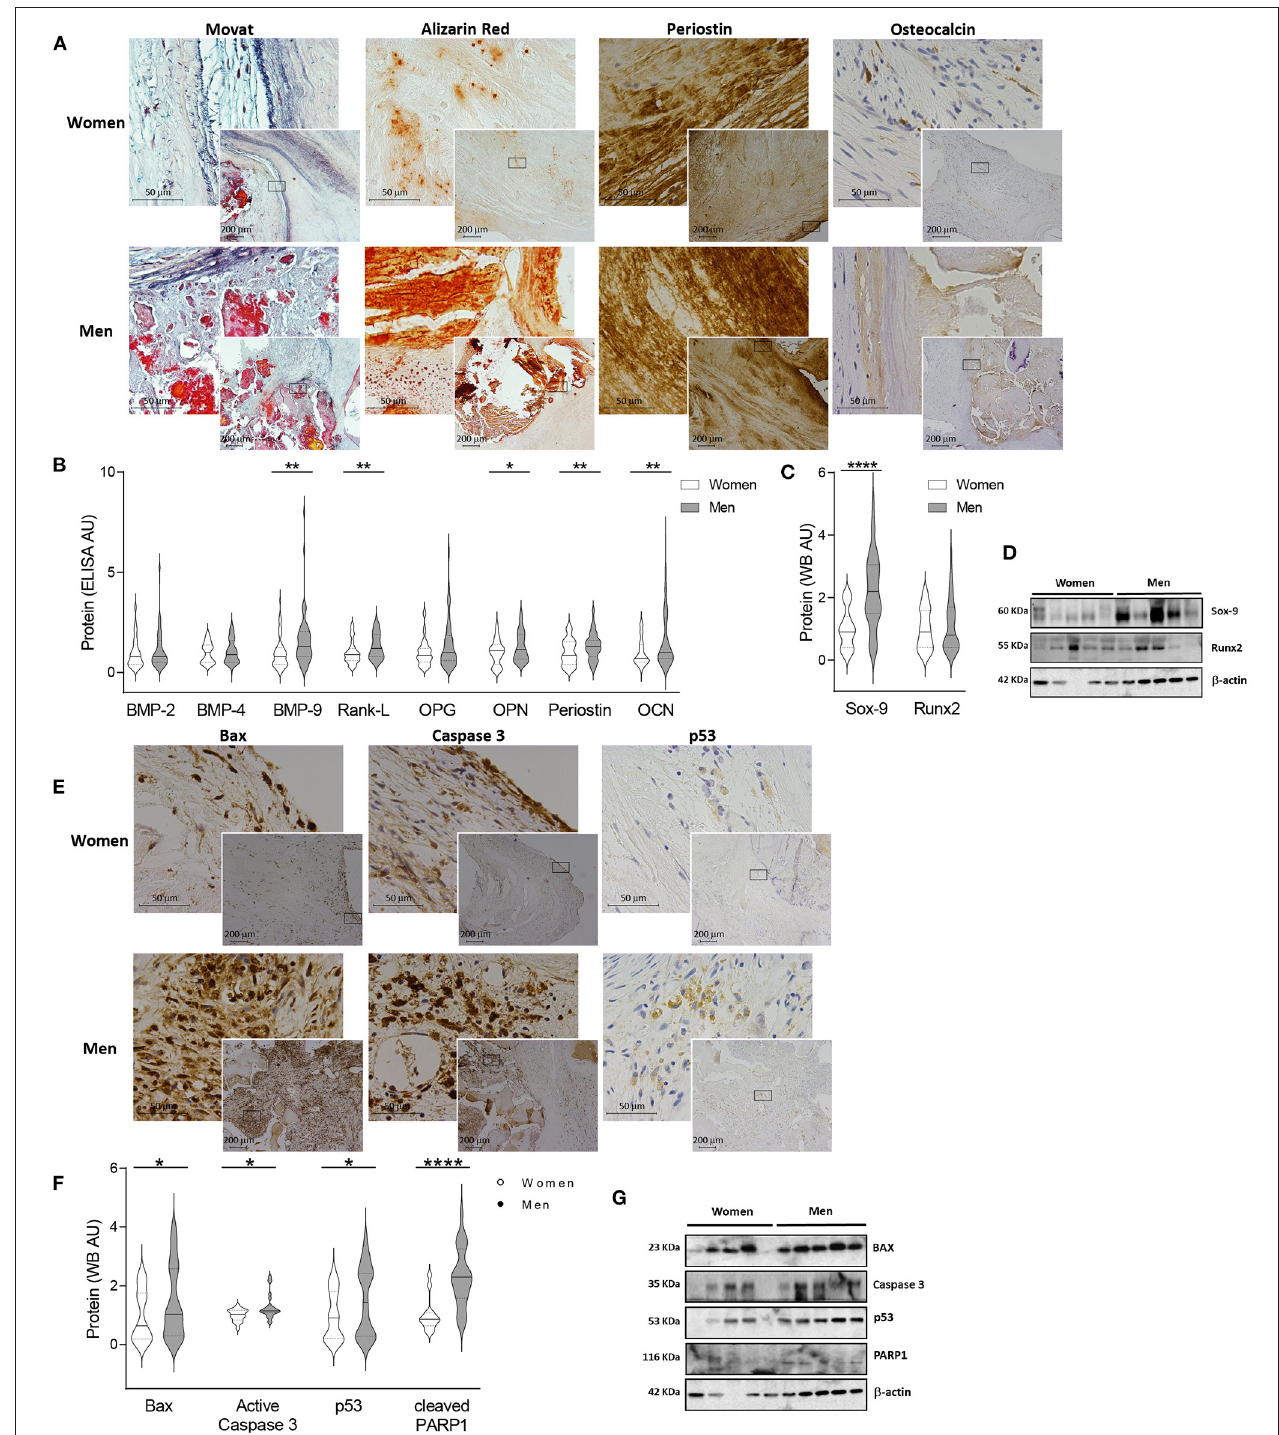
FIGURE 3 | Sexual dimorphism in calcification and apoptosis markers in human AVs. Representative images for Movat, Alizarin red (AR), periostin and osteocalcin staining in women and men AVs slides (A) . Protein expression of calcification markers in women and men AV tissues measured by ELISA (B) and western blot (C) . Representative western blot images for calcification markers (D) . Representative microphotographs of Bax, Caspase 3 and p53 immunostainings in women and men AV tissues (E) . Protein expression of apoptosis markers in women and men tissue homogenates (F) . Representative blots for apoptosis markers (G) . AS, aortic stenosis; AV, aortic valve; BMP, bone morphogenetic protein; Rank-L, Receptor activator of NF-kappa B ligand; OPG, osteoprotegerin; OPN, osteopontin; OCN,